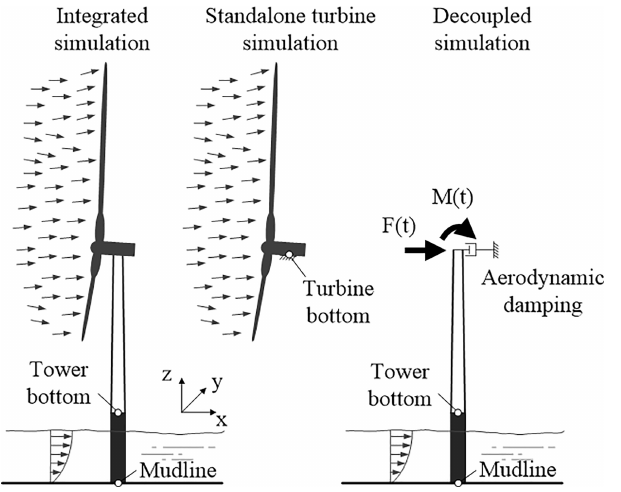
Figure 1. Offshore wind turbine and simulation